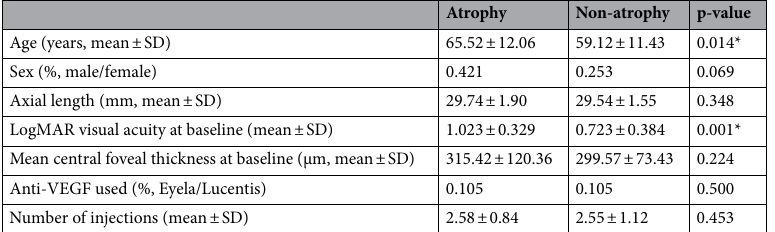
Table 5. Characteristics of the atrophy and non-atrophy groups. *Compared with baseline: p < 0.05. SD standard deviation, VEGF vascular endothelial growth factor.